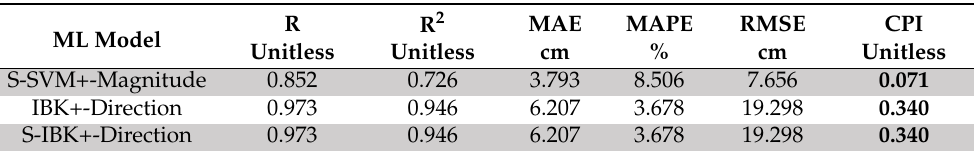
Figure 9. Best results of the predicted data points (25% database) versus the measured data points (75% database) on impact magnitude ( a ) and impact direction ( b , c ) under the wireless sensing mode. The plotted data represent 25% of the parent database that was not previously included in the training process of the ML models. The dashed line represents the line of ideality, and the solid lines represent ±10% boundaries. Table 3. Selected best prediction performance on impact magnitude, direction and latitude for the wireless sensing datasets. Five statistical parameters (i.e., R, R 2 , MAE, MAPE, and RMSE) and the composite performance index (CPI) are shown.